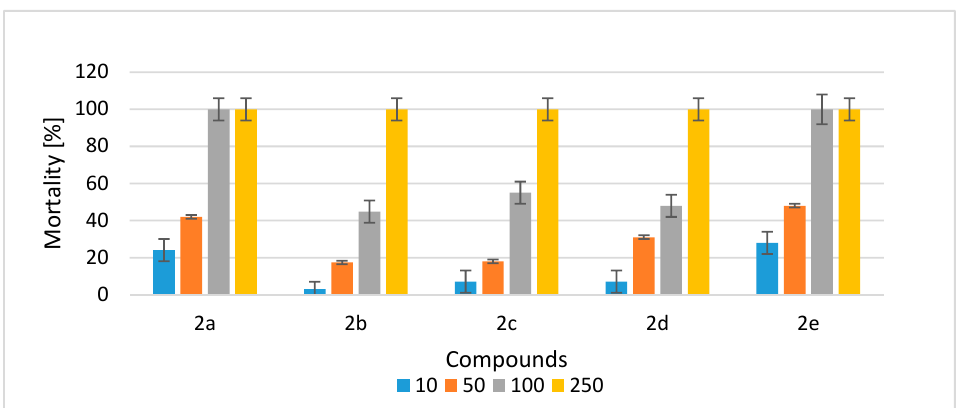
Figure 2. The mortality (%) of Heterocypris incongruens living in soil contaminated with aminophosphonates 2a – e at concentrations of 10, 50, 100 and 250 mg/kg of soil dry weight. Error bars represent standard deviation error (SD, n = 6 determinations).